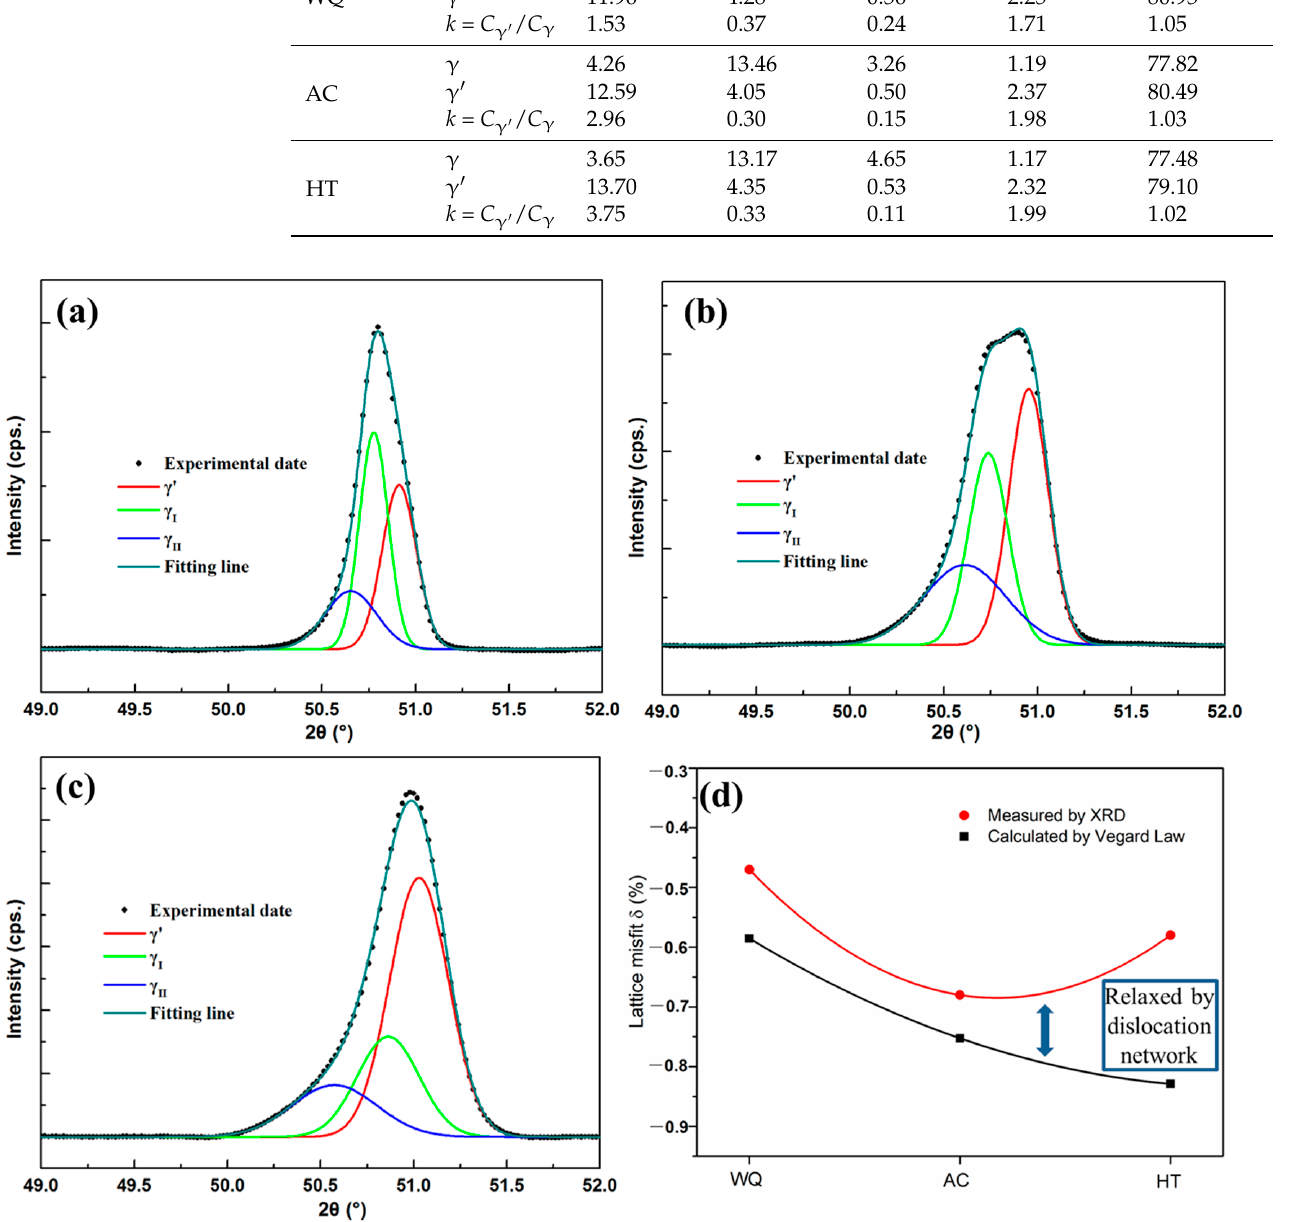
Figure 6. Diffractometer scans of (002) γ , γ′ peaks of experimental alloy after different heat treatment at room temperature: ( a ) WQ, ( b ) AC, ( c ) HT and ( d ) the lattice misfit measured by XRD and calculated by Vegard Law (the phase compositions in Table 4 were used).